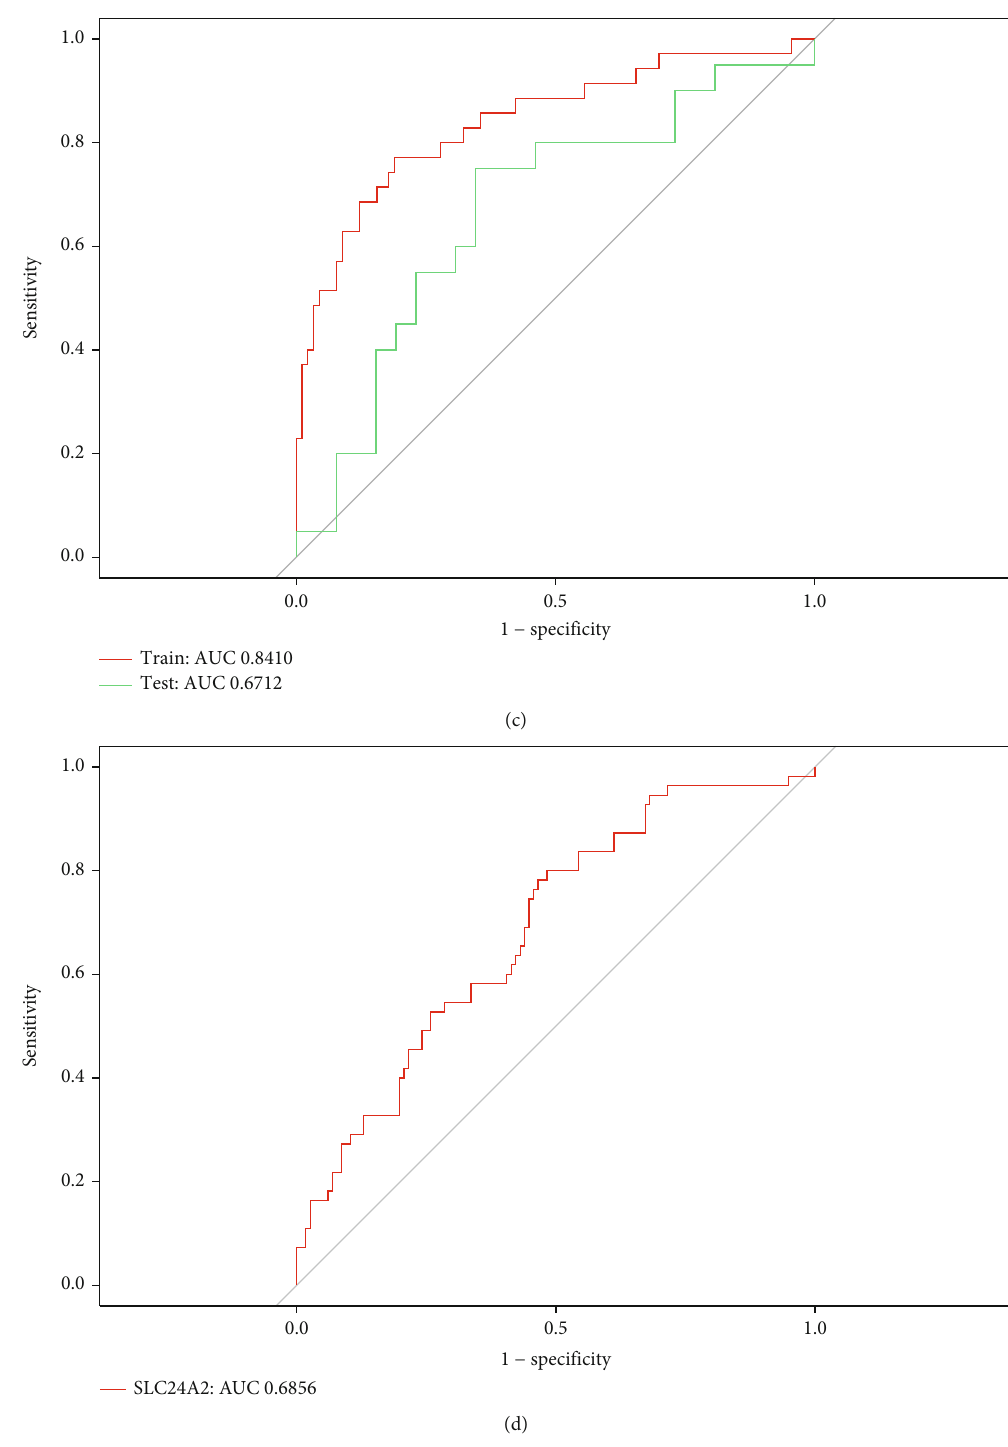
Figure 5: The LASSO model for predicting T2D. (a, b) LASSO model. (c) ROC analysis of train set and validation set. (d) ROC analysis of SLC24A2 . LASSO: least absolute shrinkage and selection operator; ROC: receiver operating characteristic